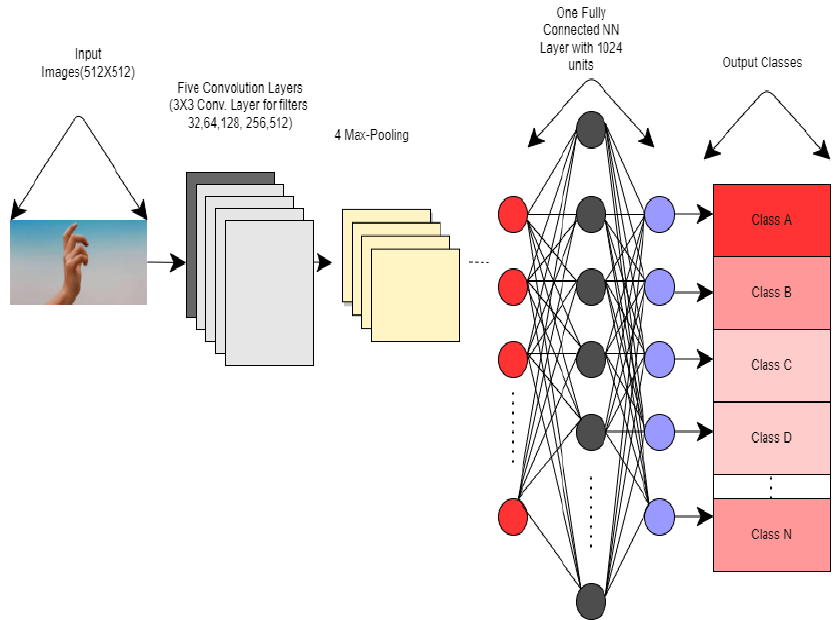
Figure 1. Internal Network Architecture of CNN for hand Gesture.